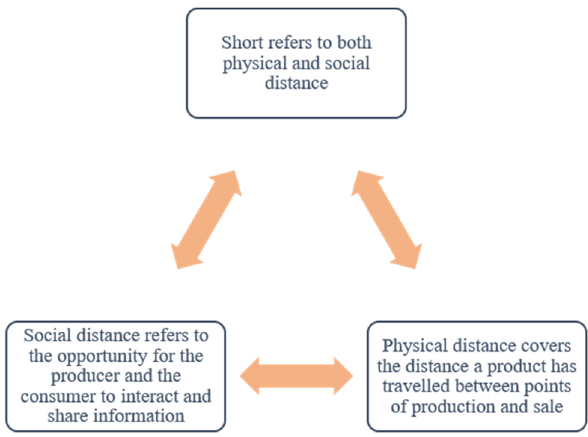
Figure 1: The meaning of “ Short ” . Source: Adapted from Galli and Brunori ( 2012 ) .